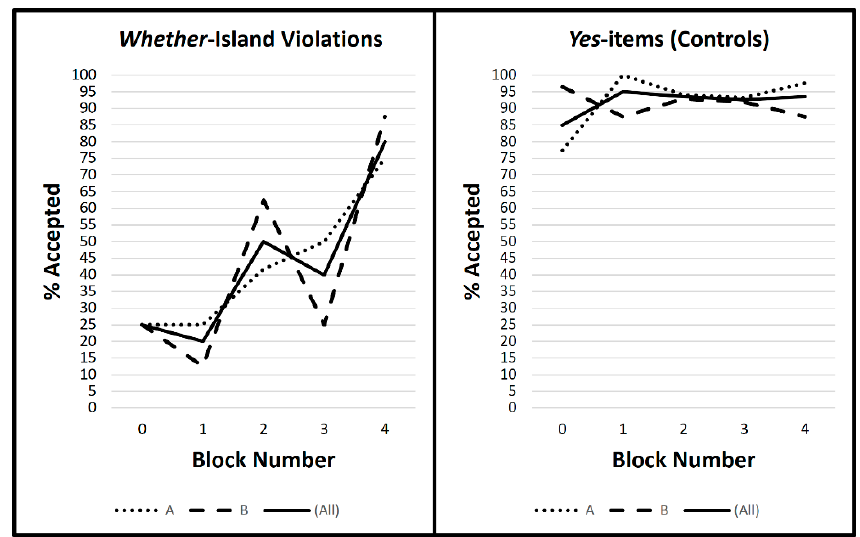
Figure 1. ( Left ) Percentage of participants in each block of Experiment I, who accepted the Whether- Island violation; Version A ( N = 12) used forward presentation; Version B ( N = 8) used reverse order; “All” indicates the total ( N = 20). ( Right ) Mean percentage of the “Yes” items that were accepted; each participant judged seven items per block.